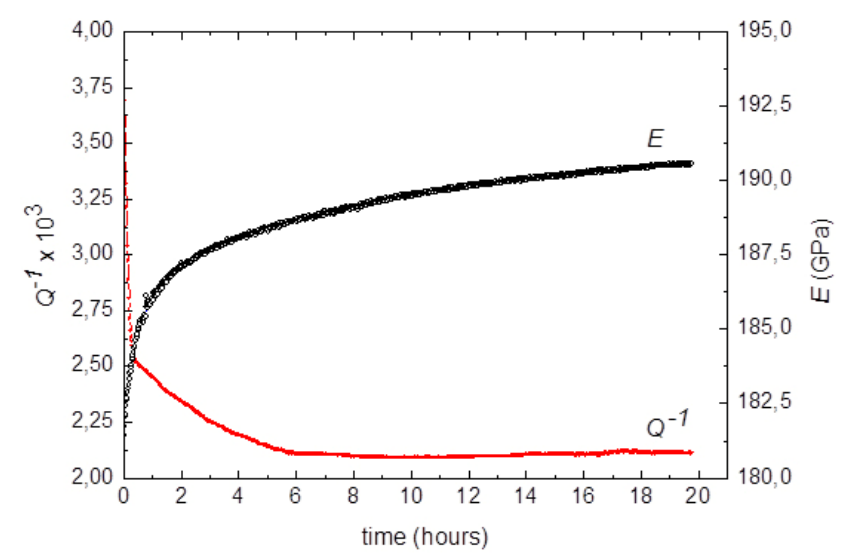
Figure 2. AISI 304 steel: Q − 1 and E evolution during an isothermal heat treatment at 400 °C for 20 h.